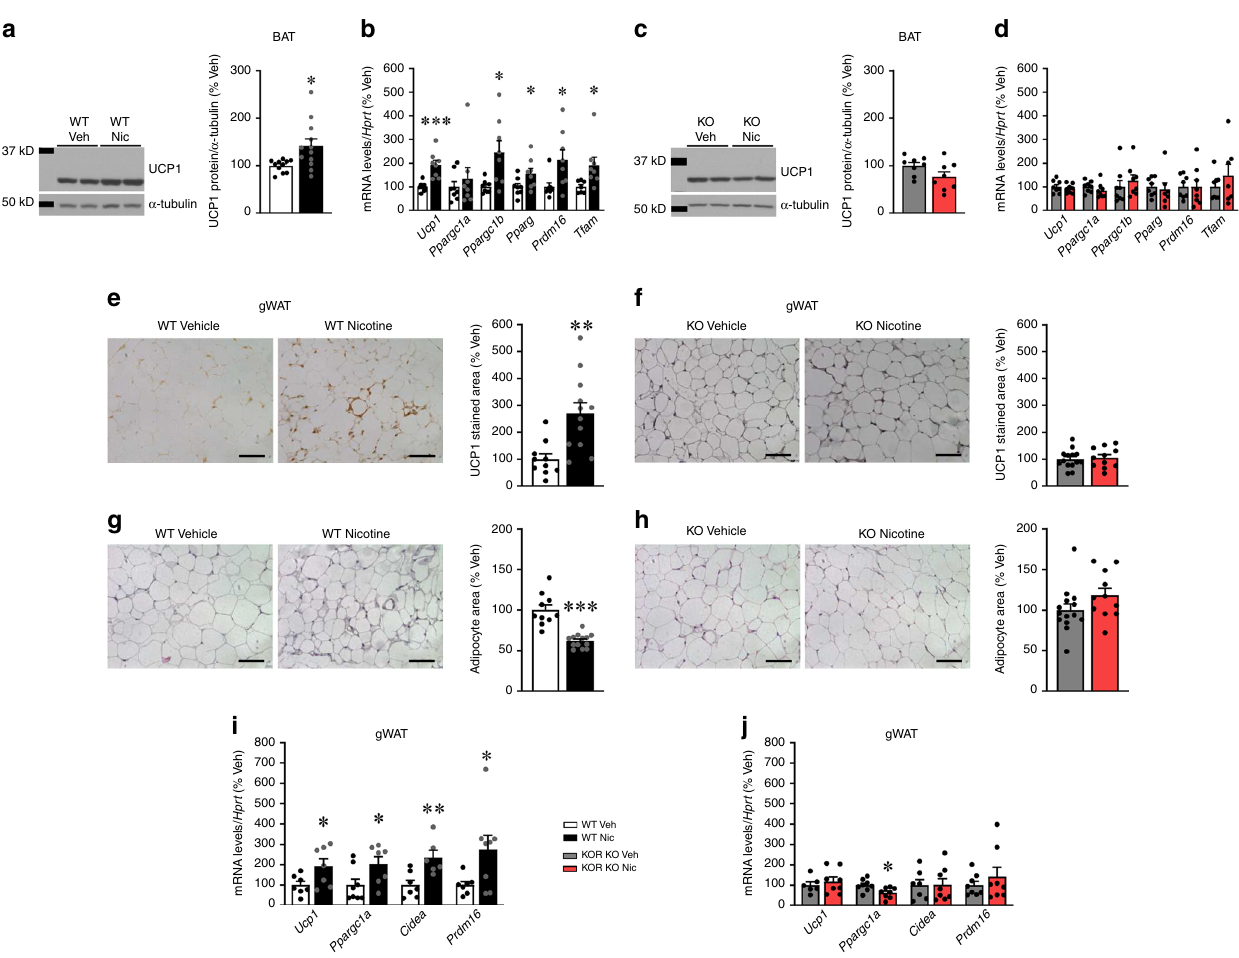
Fig. 4 Effect of nicotine on BAT and WAT in KOR null mice. a – c Representative images (left panels) and protein levels of UCP1 in the BAT (right panels) (WT vehicle n = 11, WT nicotine n = 12, KO vehicle n = 8, KO nicotine n = 8 mice). b – d mRNA levels of thermogenic markers in the BAT (WT vehicle n = 8, 8, 8, 8, 8, 7, WT nicotine n = 8, KO vehicle n = 8, KO nicotine n = 8, 8, 8, 7, 8, 7 mice). e – f UCP1 staining (left panels 40×, scale bar: 100 μ m) and UCP1 stained area (right panels) in gWAT (WT vehicle n = 10, WT nicotine n = 12, KO vehicle n = 14, KO nicotine n = 11 mice). g – h H&E staining (left panels 40×, scale bar: 100 μ m) and adipocyte area (right panels) in gWAT (WT vehicle n = 10, WT nicotine n = 13, KO vehicle n = 14, KO nicotine n = 11 mice). i – j mRNA levels of thermogenic markers in the gWAT (WT vehicle n = 7, 8, 7, 7, WT nicotine n = 7, 7, 6, 8, KO vehicle n = 6, 8, 7, 8, KO nicotine n = 8, 8, 8, 8 mice) of WT ( a , b , e , g and i ) or KOR KO ( c , d , f , h and j ) mice treated with vehicle or nicotine. Center values represent average; error bars represent SEM. Statistical signi fi cance was determined by two-sided t -Student; * P < 0.05, ** P < 0.01, *** P < 0.001 vs. vehicle. The experiments were repeated two times; the samples represent biological replicates. In the panels a and c showing images of gels, all the bands for each picture come from the same gel but they have been spliced for clarity. Source data are provided as a Source Data fi